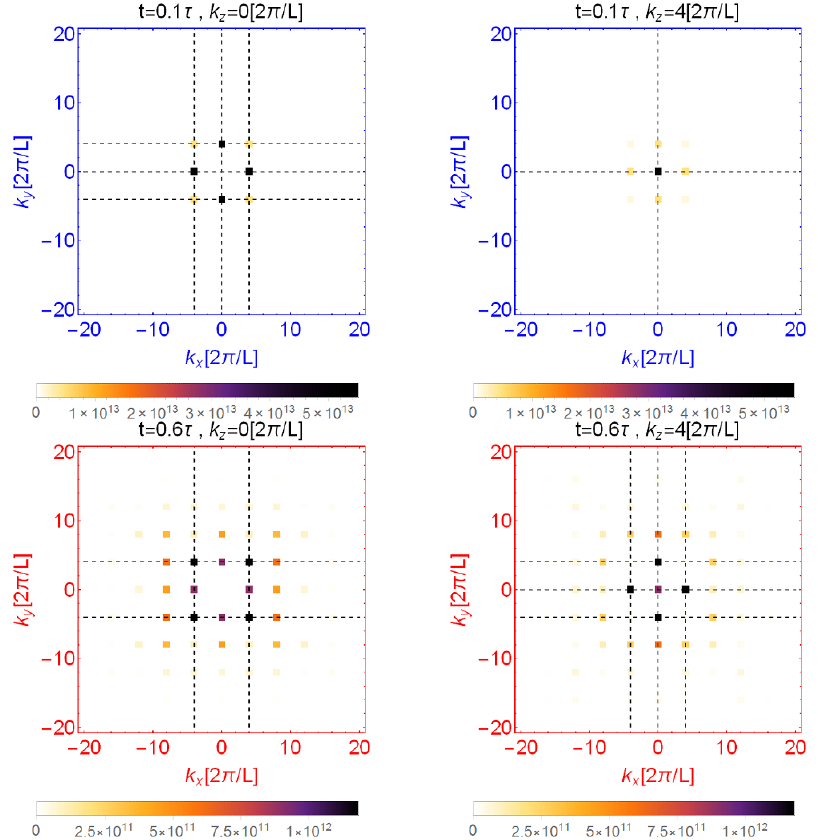
p p ( t; ~x ) ~u ( t; ~x ) e (cid:0) i~k (cid:1) ~x